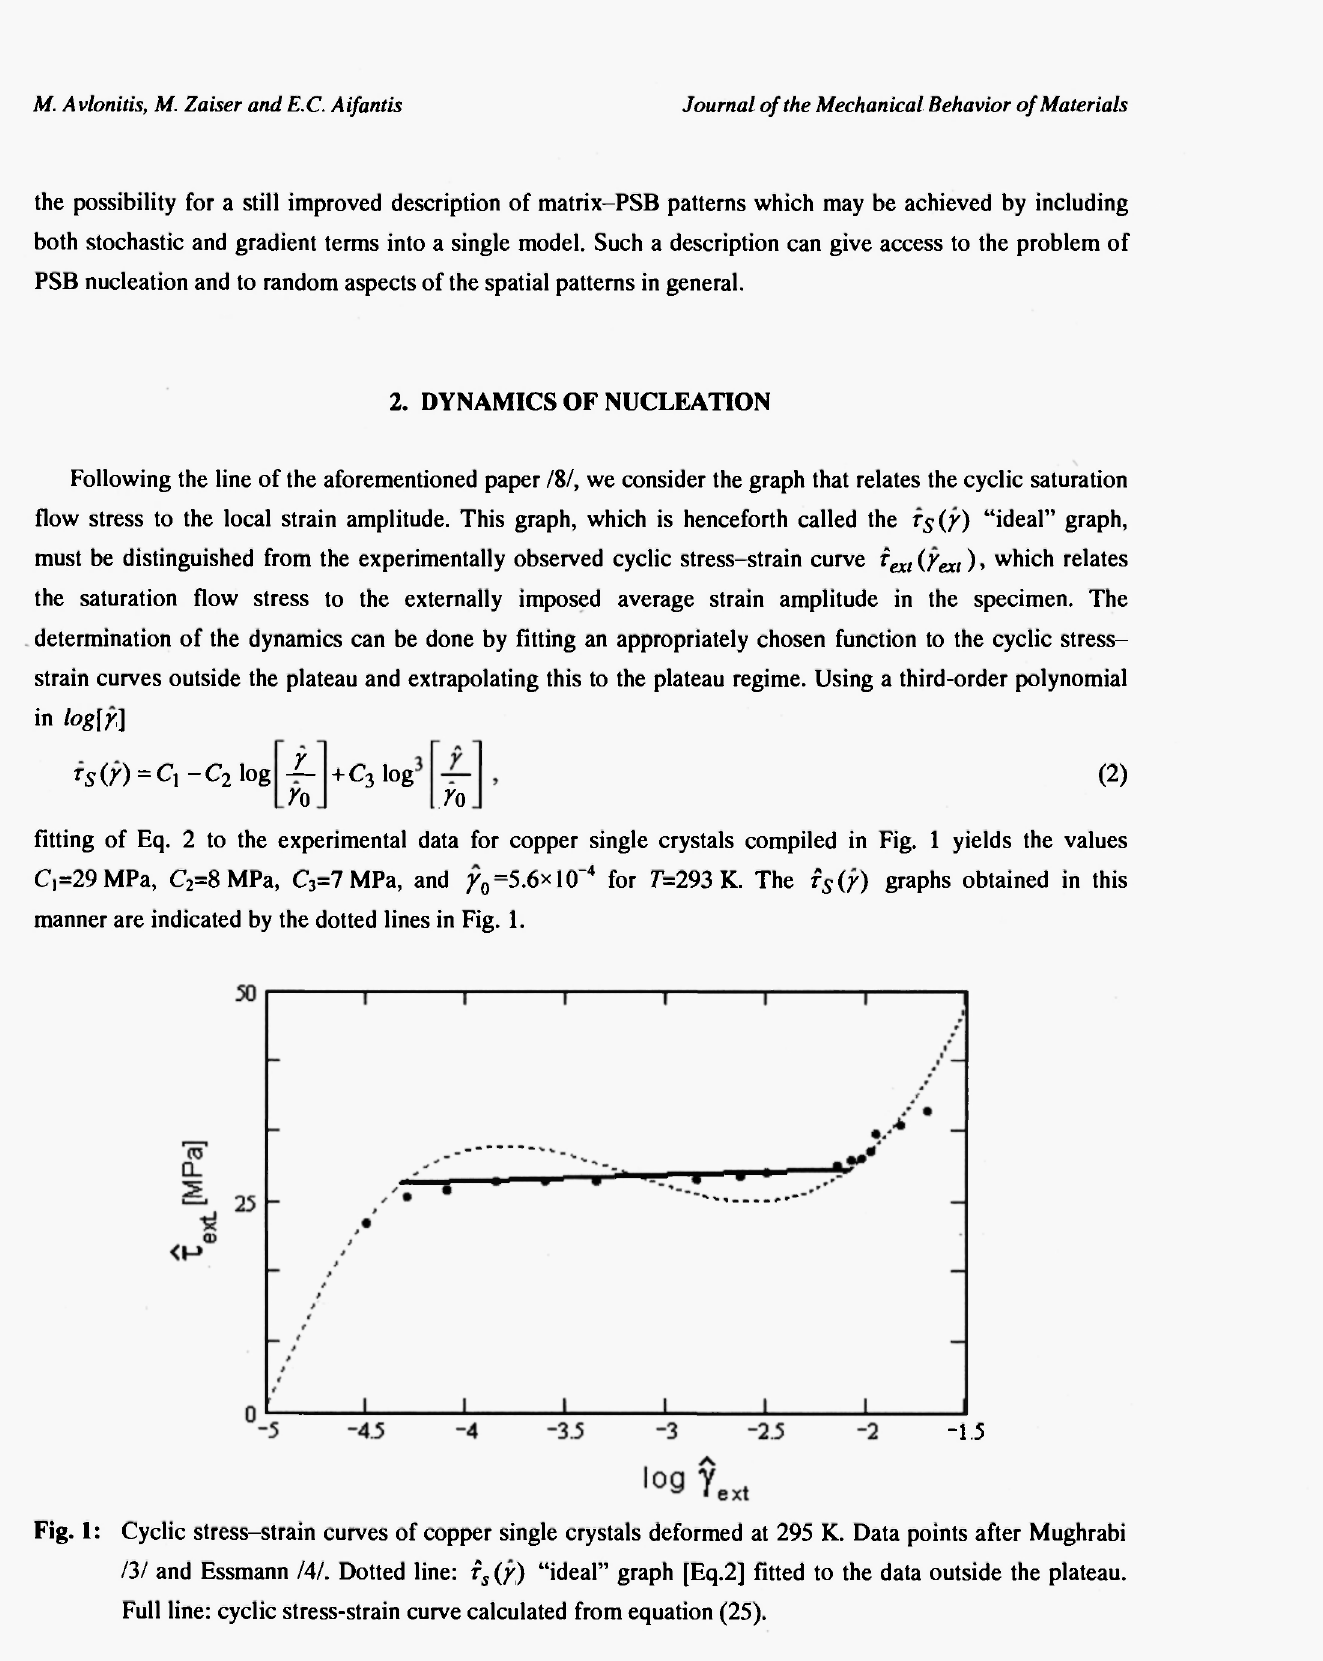
Fig. 1: Cyclic stress-strain curves of copper single crystals deformed at 295 K. Data points after Mughrabi 13/ and Essmann /4/. Dotted line: i s (y) "ideal" graph [Eq.2] fitted to the data outside the plateau. Full line: cyclic stress-strain curve calculated from equation